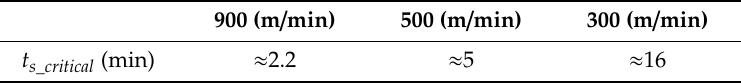
Table 6. Average value of tool life for various cutting speed.